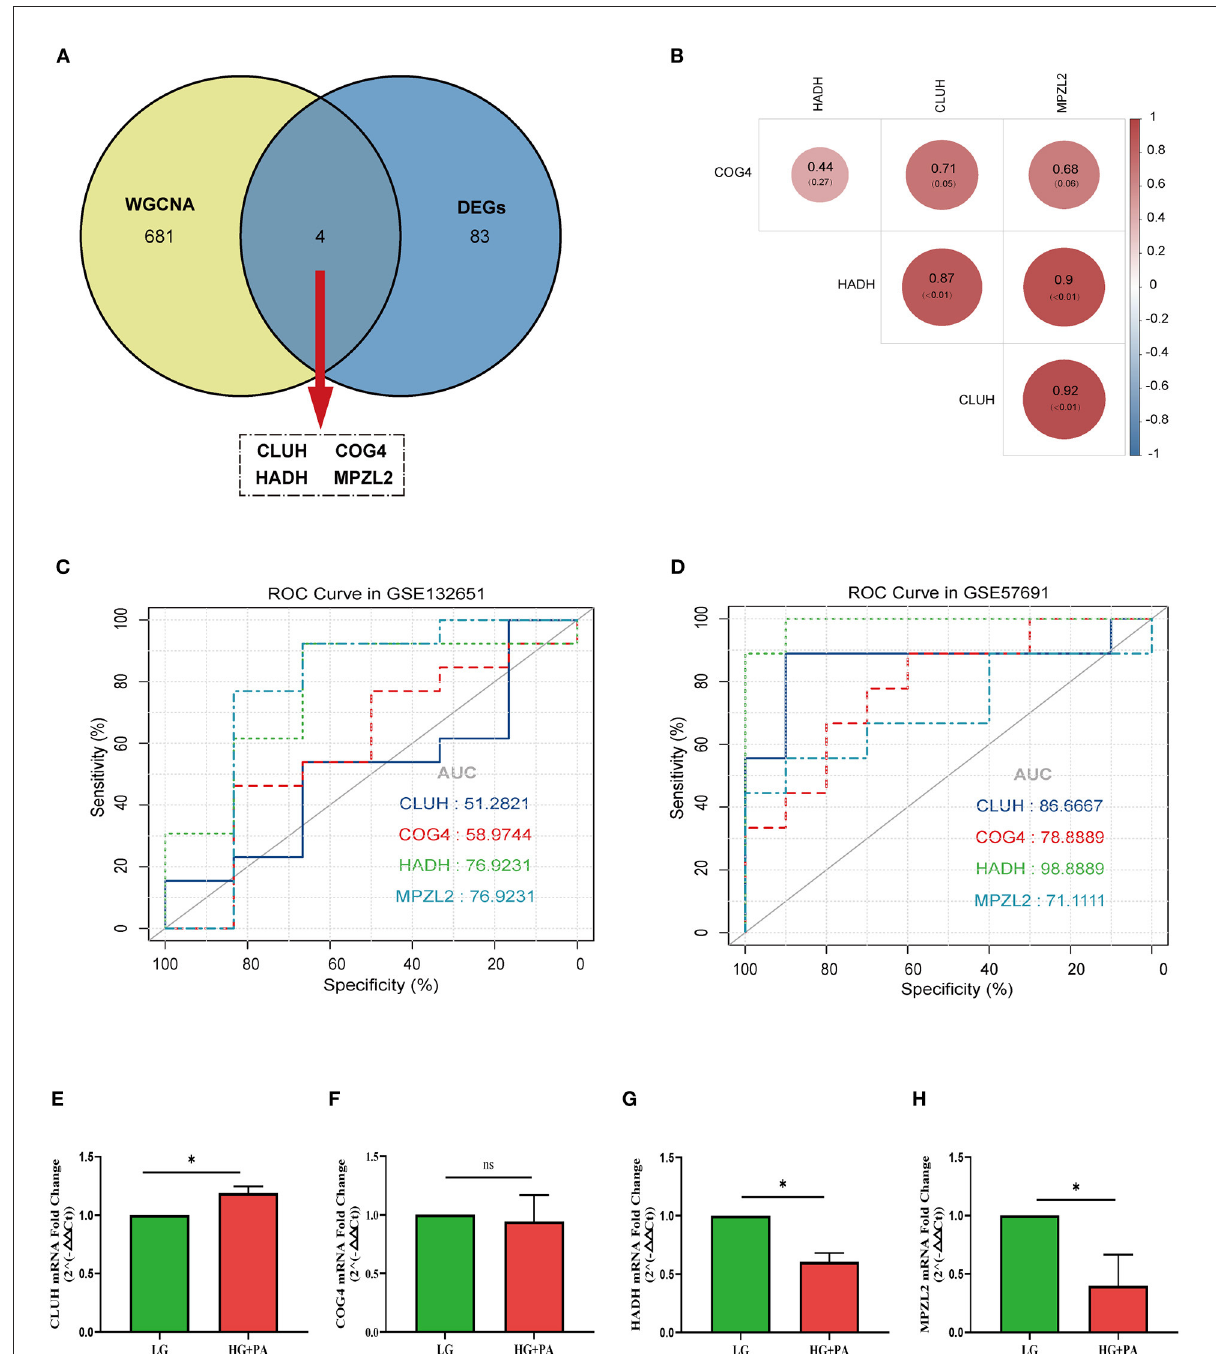
FIGURE5 Analysis and validation of target genes. (A) Venn diagram of common genes between differential expression genes (DEGs) and trait-module genes in weighted gene co-expression network analysis (WGCNA). (B) The correlation analysis of target genes. (C) Receiver operating characteristic curve (ROC curve) of target genes in GSE132651. (D) ROC curve of target genes in GSE57691. The mRNA fold change of CLUH (E) , COG4 (F) , HADH (G) , and MPZL2 (H) in human coronary artery endothelial cells (HCAECs) treated with high glucose (HG) and palmitic acid (PA). * p < 0.05; ns p >